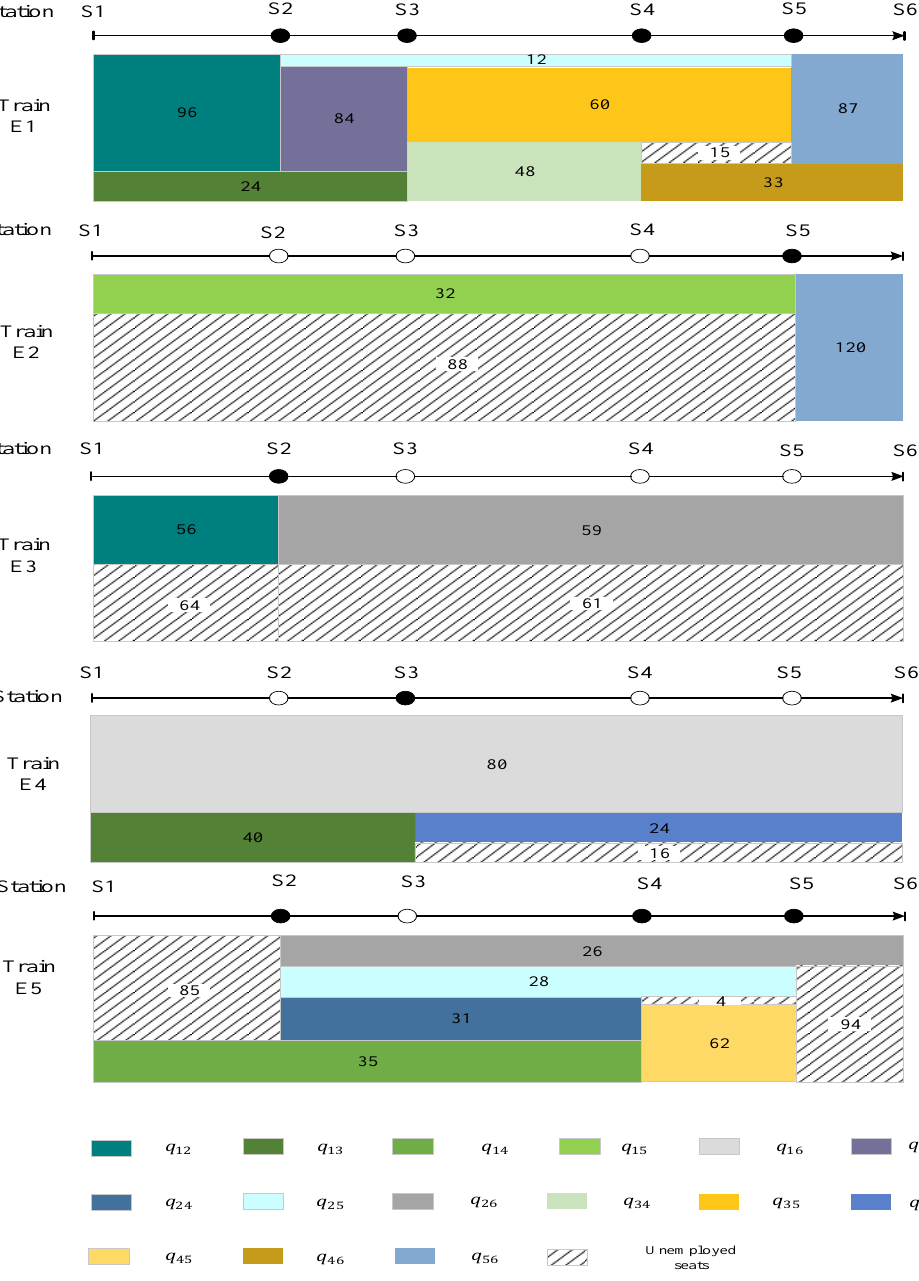
Figure 4. Passenger distribution for existing trains. Table 6. Passenger demand for each OD in peak period.